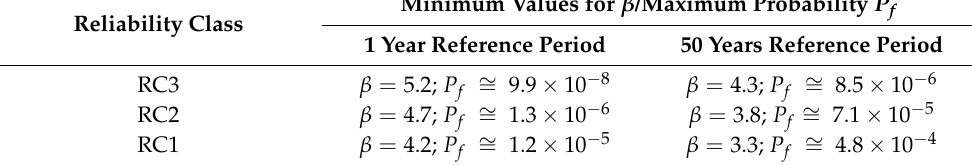
Table 4. Recommended minimum values for reliability index and maximum probability of destruc- tion (ultimate limit states) (PN-EN 1990